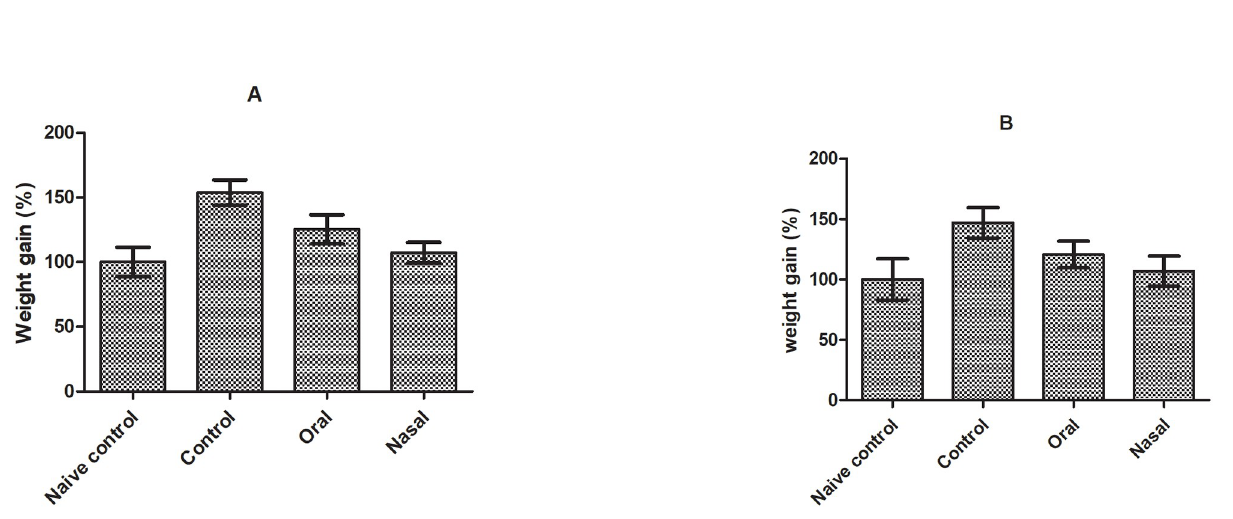
PLOS ONE | https://doi.org/10.1371/journal.pone.0277849 November18,